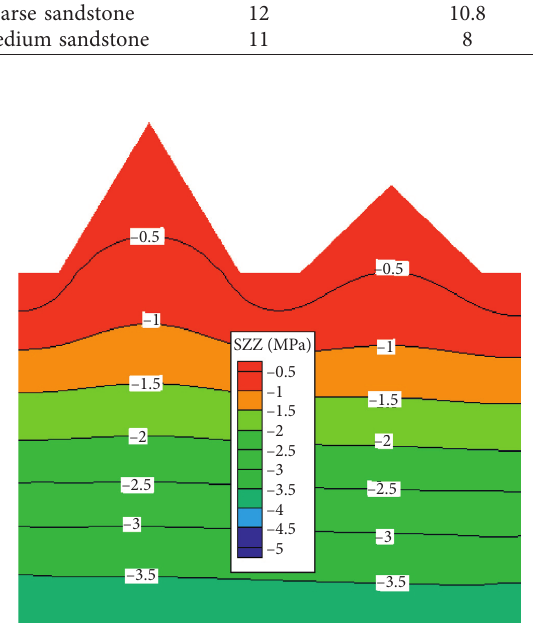
Figure 5: Distribution of SZZ.